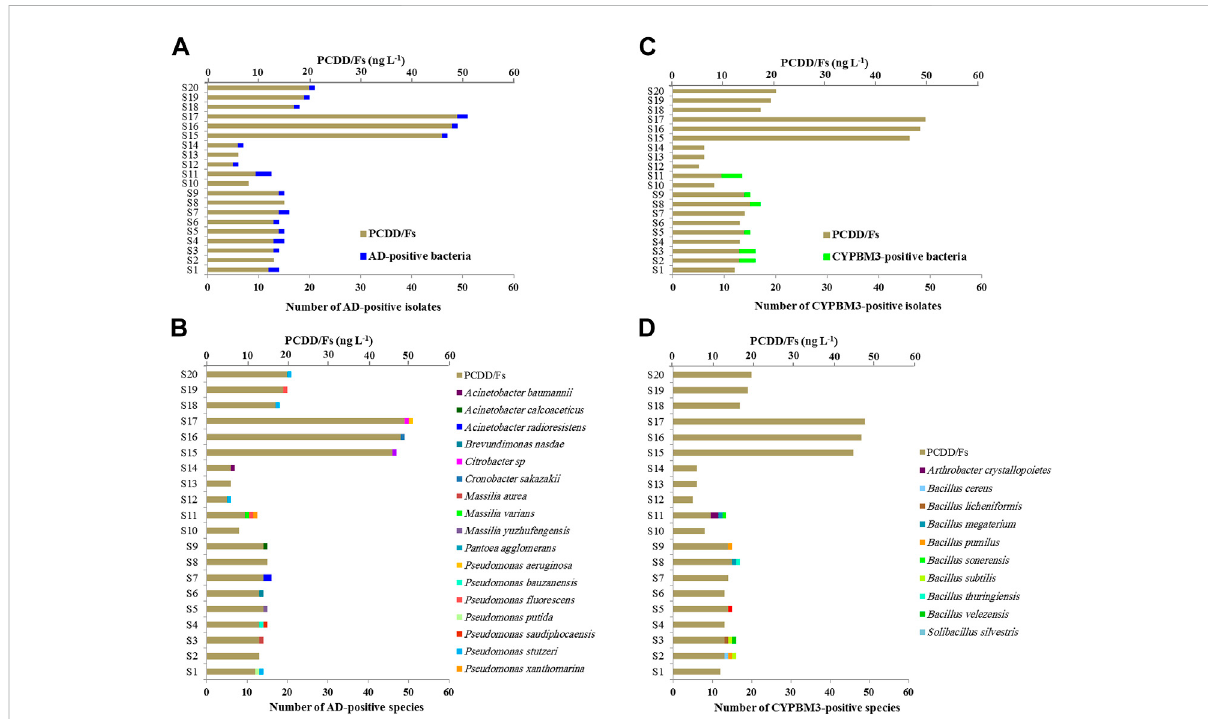
FIGURE 4 Geneticscreeningfordioxin-degradinggenesinbacterialcommunities.Screeningfordioxin-metabolizinggenesinbacterialisolateswasdone using gene-speci fi c primers against the bacterial angular dioxygenase ( AD ) and cytochrome P450 CYPBM3 . (A , C) The number in AD-positive or CYPBM3-positivebacterialisolates inconnection with theconcentrationofPCDD/Fs insoilsamples arepresented respectively. (B , D) Distribution of bacterial species among the soil samples. The number of isolates from each species found in the soil samples are